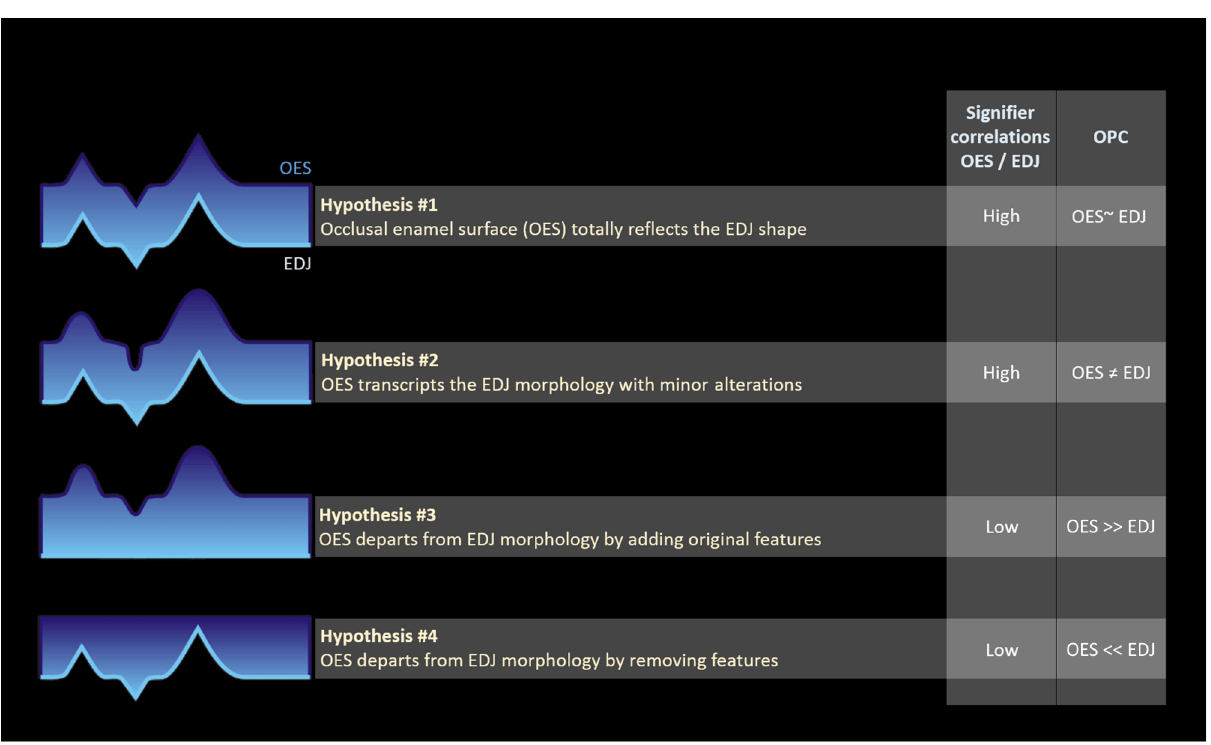
Fig 1. Working hypotheses on the relationships between OES/EDJ morphologies OES, occlusal enamel surface; EDJ, enamel-dentine junction; OPC, orientation patch count The four hypotheses on how the OES echoes EDJ morphology are considered Following hyp #1 the correlation between the EDJ and the OES is expected to be total and both organs are expected to show the same amount of occlusal complexity (OPC); hyp #2 , the correlation between the EDJ and the OES is expected to be high and both organs are expected to show different amount of occlusal complexity; hyp #3 , the correlation between the EDJ and the OES is expected to be low and the OES is expected to show greater amount of occlusal complexity; hyp #4 , the correlation between the EDJ and the OES is expected to be low and the OES is expected to show lower amount of occlusal